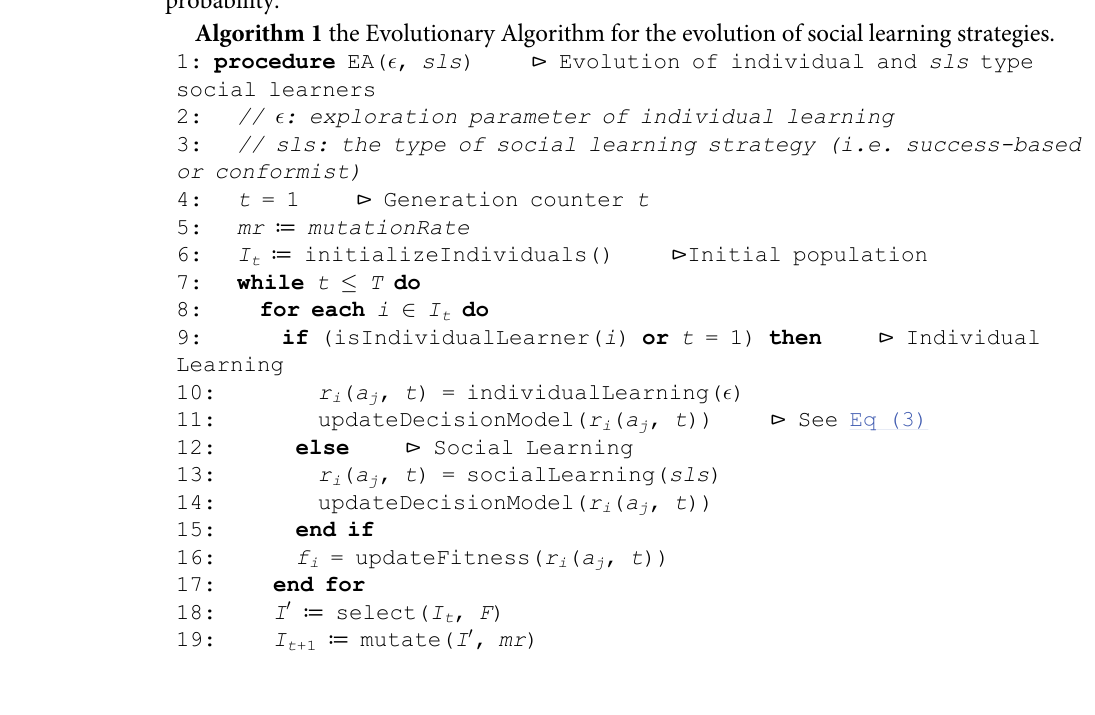
[28, 70]. Individuals are assigned one of these types randomly during the initialization process.